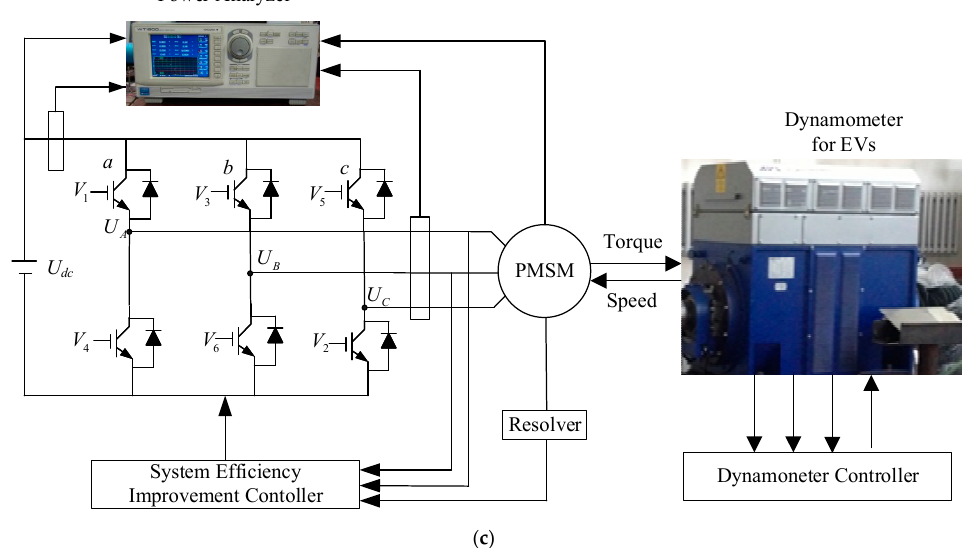
Figure 9. Experimental platform of PMSM drive system. ( a ) Si-IGBT based inverter; ( b ) Physical prototype experimental platform; ( c ) Diagram of the experimental platform. Table 1. Parameters of the outer rotor surface PMSM.